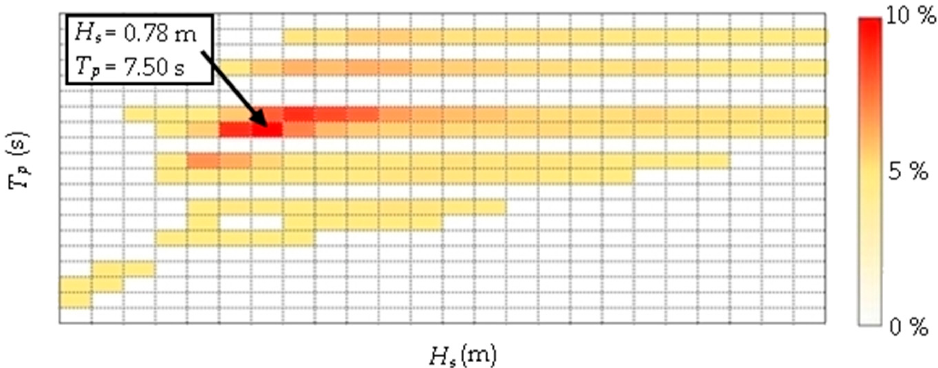
Figure 4. Histogram of frequency of occurrence of sea state for the point referring to TV. region, the wavelengths ( λ ) were calculated using the dispersion relation